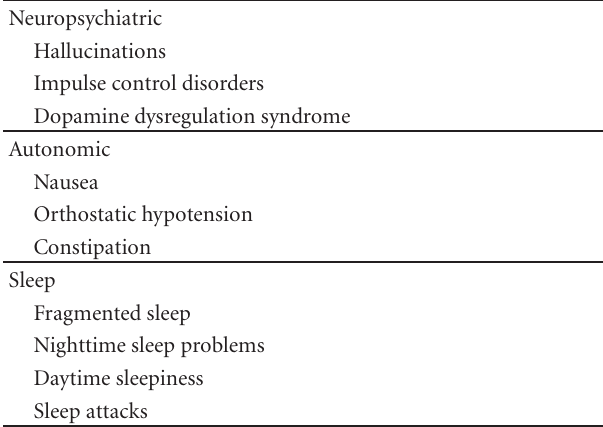
Table 1: Dopamine-induced nonmotor symptoms of Parkinson’s